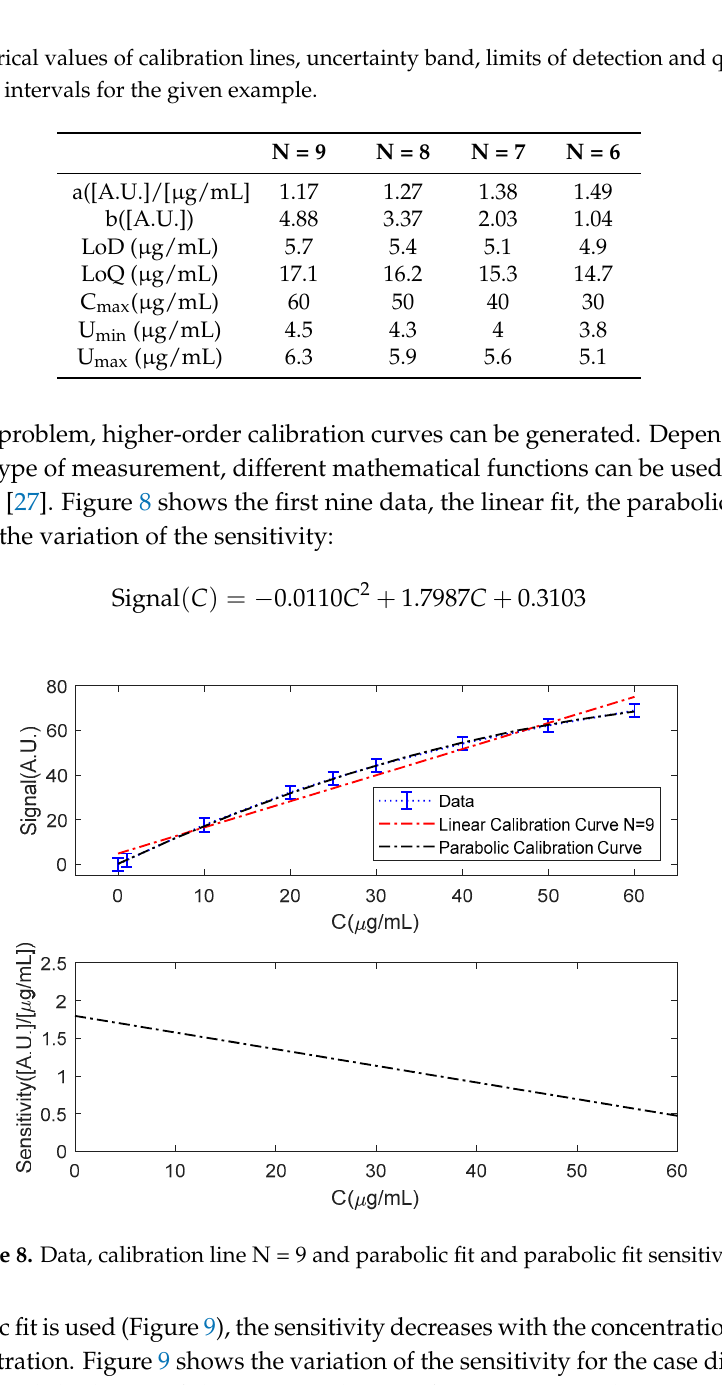
Figure 9. Data, calibration curve for parabolic fit, uncertainty band, limits of detection and quantification and measuring intervals for the given example.